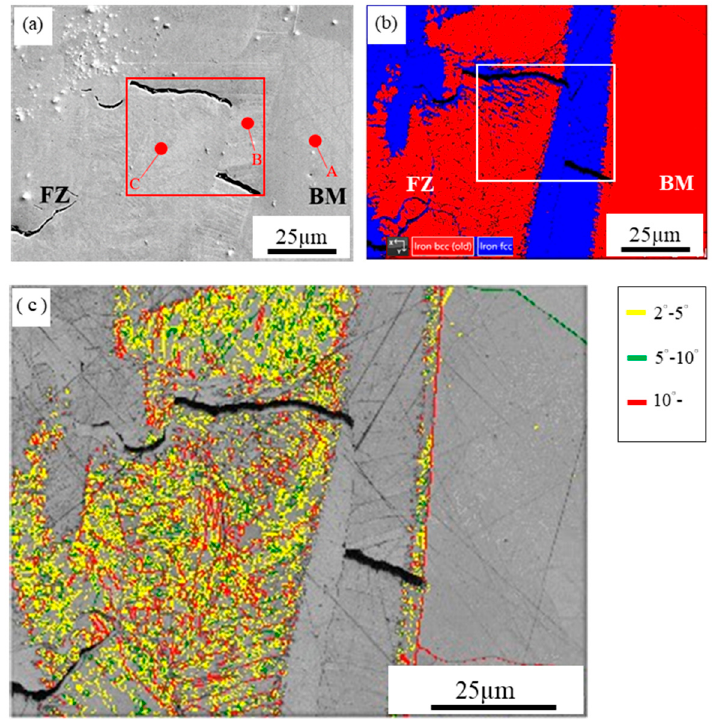
Figure 4. Selected area in Figure 2a at higher magnification: ( a ) EPMA SEI, ( b ) EBSD crystallographic map, ( c ) EBSD boundary misorientation